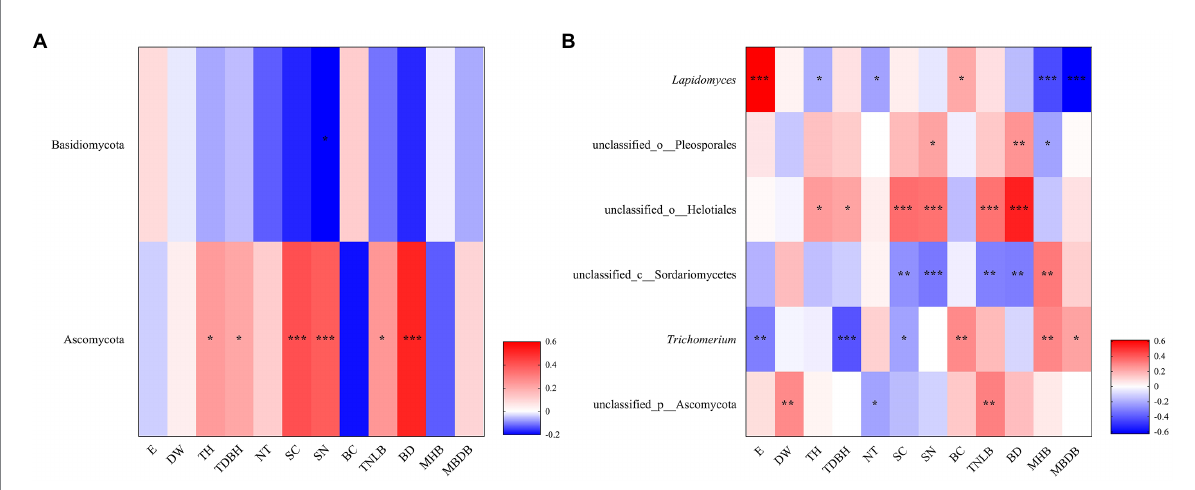
FIGURE 5 Correlation heatmap showed the relative abundance of fungi phylum (A) and genus (B) in relation to environmental factors. R is shown in different colors, and the legend on the right is the color range of different R values. E, elevation; DW, water source distance; TDBH, trees diameter at breast height; TNLB, total number of live bamboo; SC, shrub coverage; BD, bamboo deaths; SN, shrubs numbers; TH, trees height; SH, Shrub height; CD, canopy density; MBDB, mean base diameter of bamboo; NT, number of trees; MHB, mean height of bamboo; S, Slope; BC, bamboo coverage. (*0.01 < p < 0.05, **0.001 < p < 0.01, *** p <